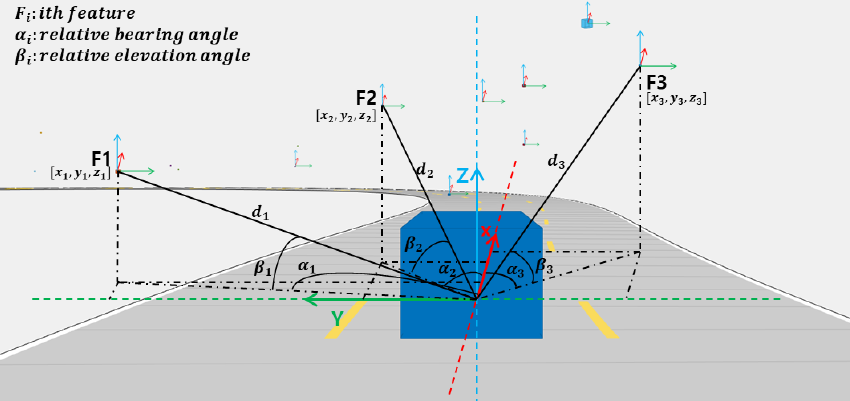
Figure 2. The effect of three-dimensional perception. Figure 2. The e ff ect of three-dimensional